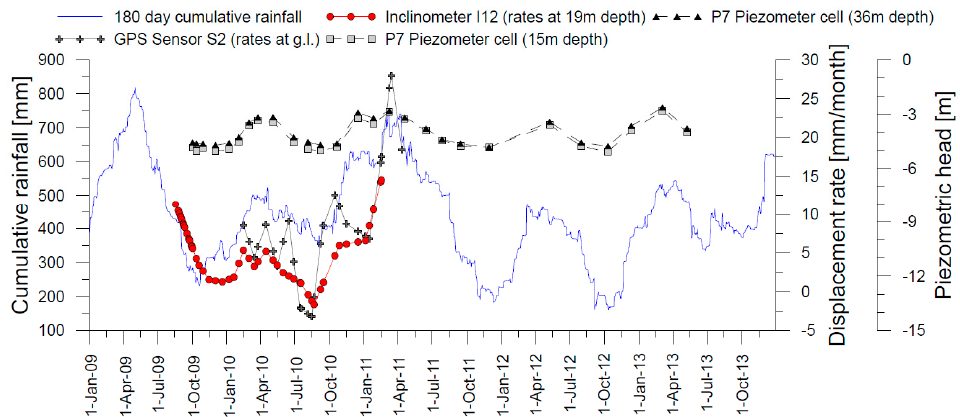
Figure 8. Pisciolo slope—180-day cumulative rainfalls and monitoring data (after [40]); for the piezometric head z = 0 at ground surface; the location of the piezometers and inclinometers cited in the legend are shown in Figure 6.